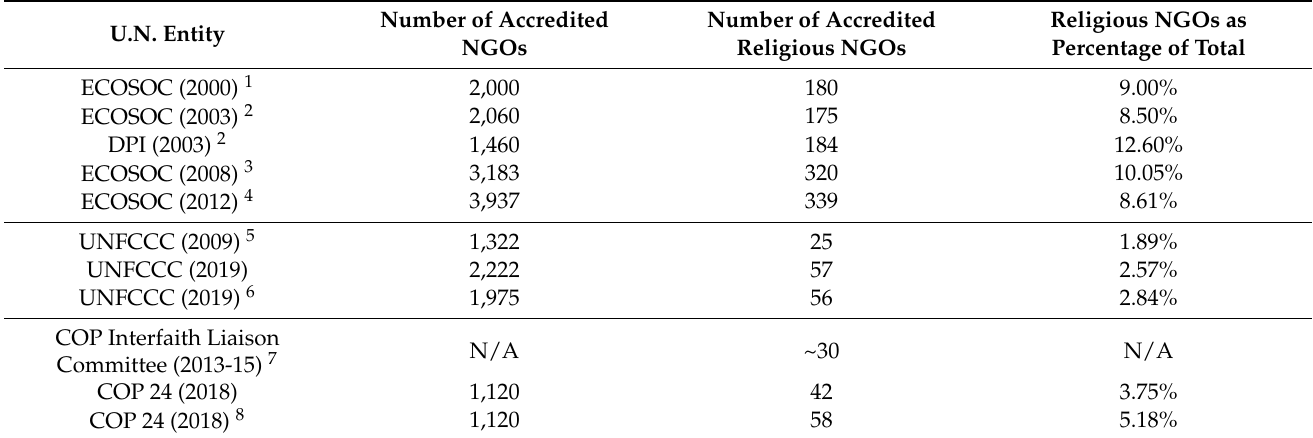
Table 5. NGO accreditation at the DPI, the ECOSOC, the UNFCCC and the COP over time. U.N. Entity